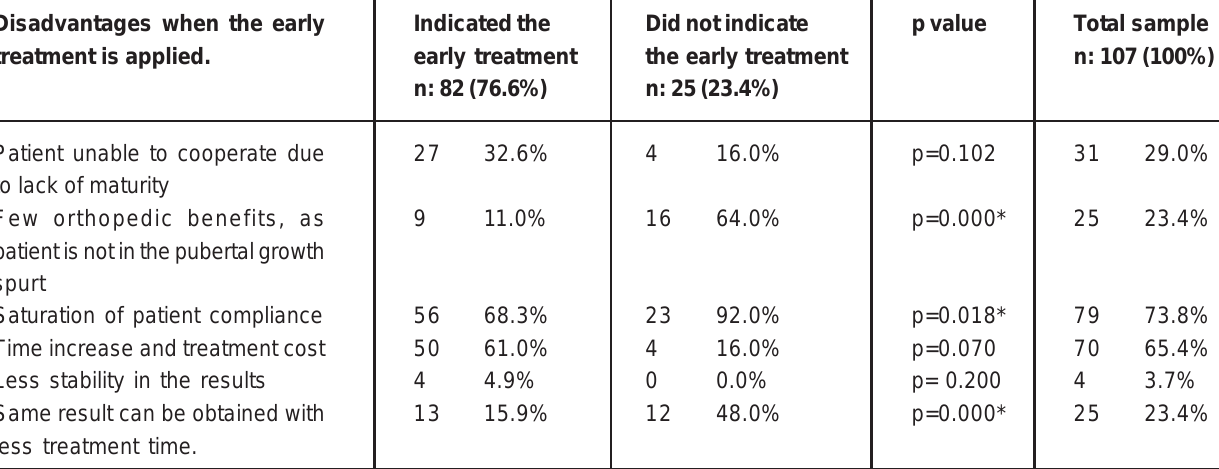
TABLE 3- Disadvantages mentioned by professors for the Class II malocclusion early treatment Disadvantages when the early treatment is